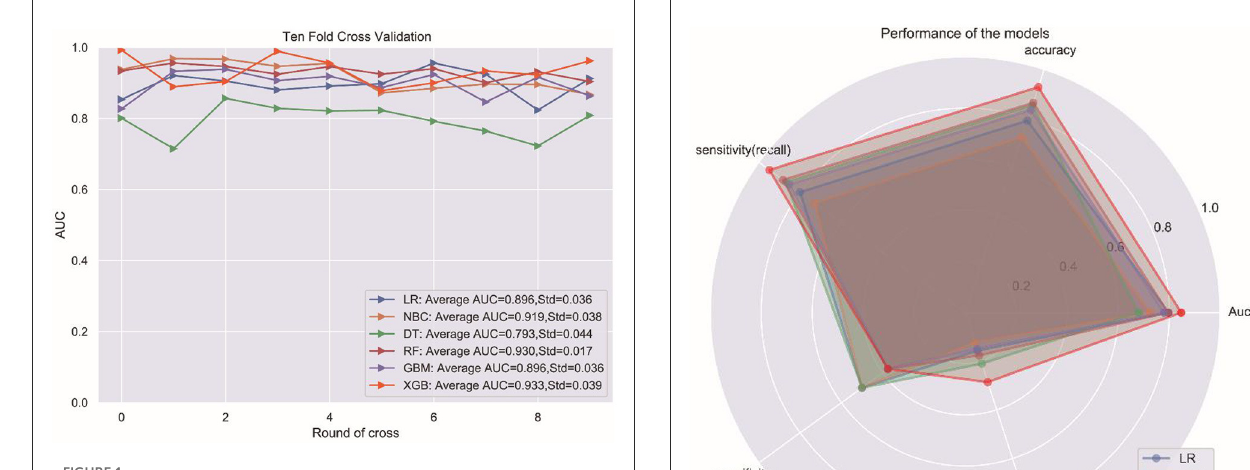
FIGURE1 Ten-fold cross validation test. LR, logistic regression; NBC, Naive Bayesian classification; DT, Decision Tree; RF, Random Forest; GBM, gradient boosting machine; XGB, extreme gradient boosting.